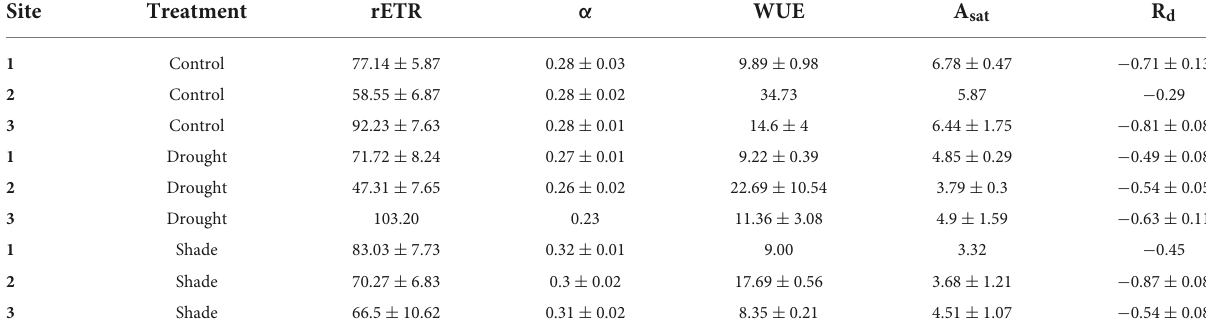
TABLE 4 Mean ecophysiological parameters ( ± se) for T. discolor in three sites under control conditions or exposed to drought or